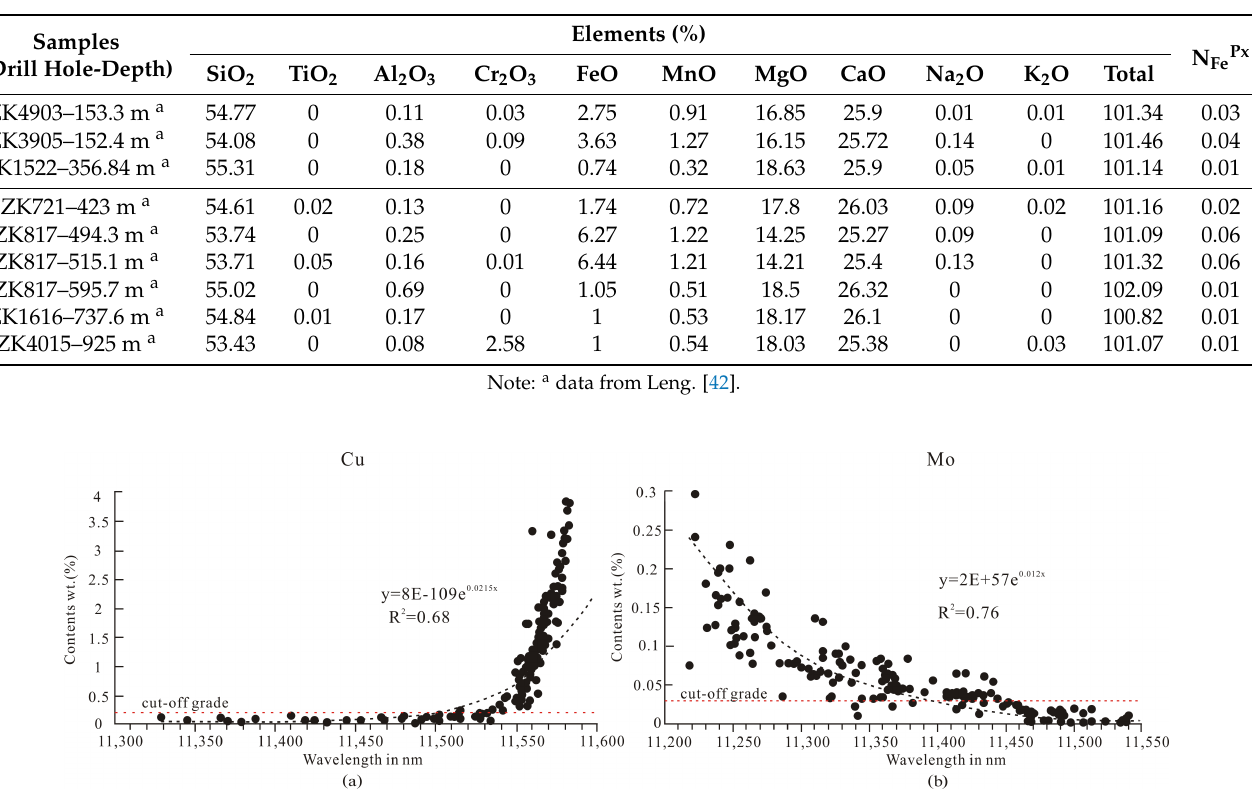
X/11/1/5/s1, Figure S1: Spectral curves of garnets with different colours; Figure S2: Spectral curves of garnets with different lithology; Figure S3: Spectral curves of garnets with different end